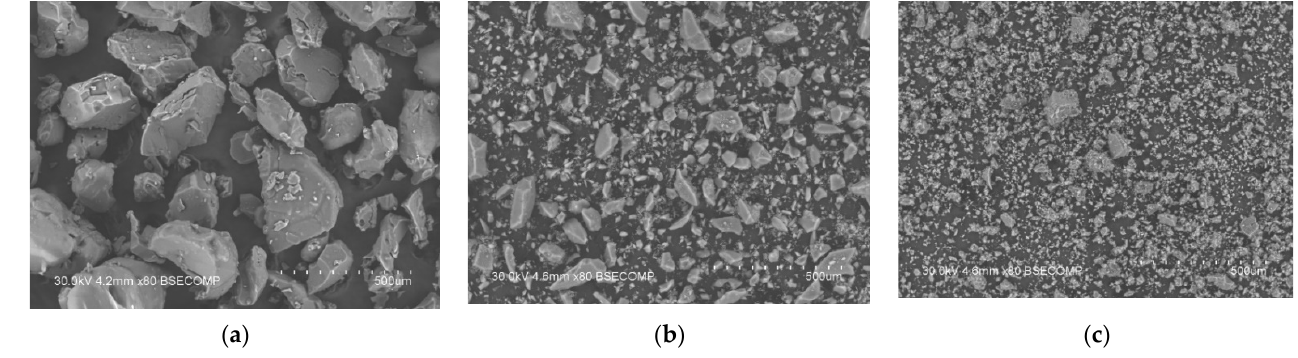
Figure 4. Scanning electron microscopy images of pure Et 4 NHSO 4 ( a ), silica ( b ) and the composite 0.2Et 4 NHSO 4 ‐ 0.8SiO 2 powders ( c ) represented at the same magnification. Pure silica powder is characterized by a wide particle size distribution, with the particle size ranging from 5 to 100 µ m (Figure 4b). The morphology of the 0.2Et 4 NHSO 4 - 0.8SiO 2 composite (Figure 4c) is similar to that for pure silica. The disappearance of large crystallites of Et 4 NHSO 4 may be explained by the imparting of the salt into the pores of the silica, the morphology of the silica particles being unaffected. Figure 5. It can be seen that the enthalpies of the endoeffects of the melting and phase transitions changed more significantly than the salt content in the composites and com ‐ pletely disappeared with an increase in x to 0.9. The temperature and enthalpy of melting for the composite when x = 0.5 were closer to the original salt (244.8 °C and ‐ 71.97 J/g, accordingly) and the enthalpy for x = 0.75 decreased markedly and was equal to ‐ 14.8 J/g. The temperature of melting shifted to 239 °C. The temperature of the phase transition also decreased to 158.7 °C. With the further increase in x to x = 0.9, the endoeffects due to the melting and phase transitions disappeared. Figure 5. D SC data for Et 4 NHSO 4 and (1 − x)Et 4 NHSO 4 − xSiO 2 composites with different composi ‐ tions. FTIR spectra for Et 4 NHSO 4 are shown in Figure 6 for hydrogen bond networks (a) and SO 4 tetrahedra and Et 4 N + (b). The wavenumbers of the stretching and bending vibra ‐ tions of the SO 4 tetrahedra in Et 4 NHSO 4 correspond to inorganic hydrogen sulfate data [29,30] and other salts with organic cations [31–33]. There were intense absorption bands